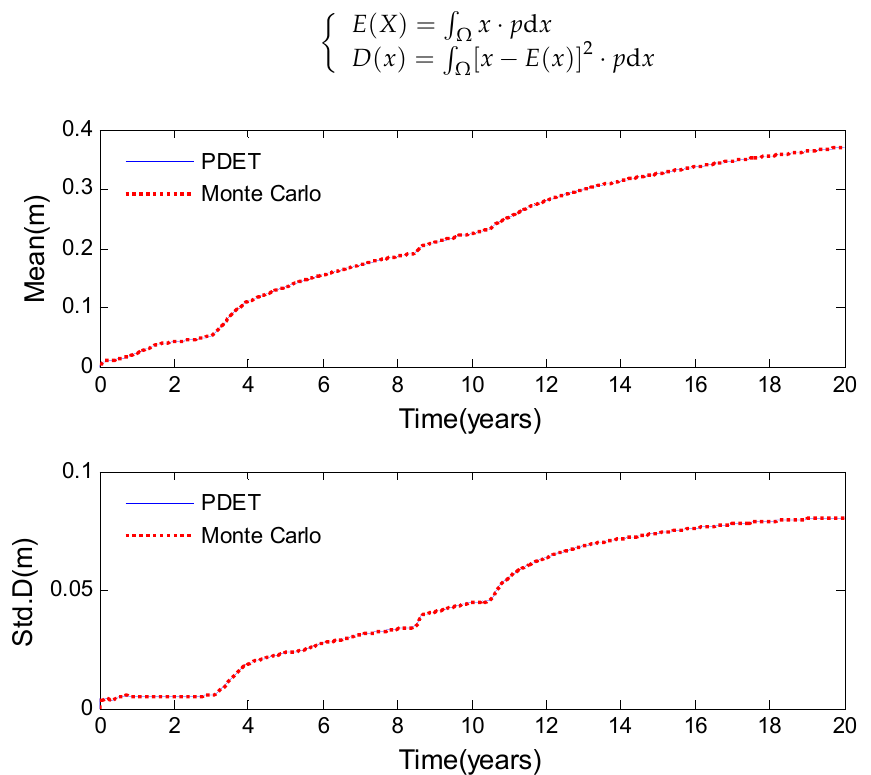
Figure 9. Evolution of the mean and standard deviations of the long-term settlement of the subway track with time.